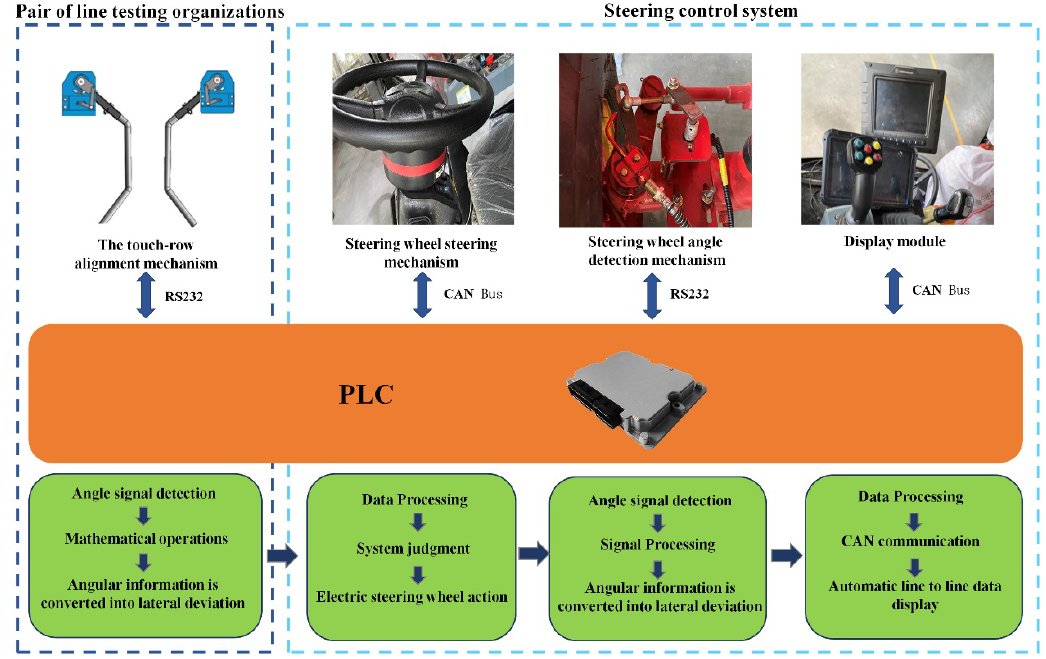
Figure 2. Working principle of automatic row alignment system for corn harvesters.